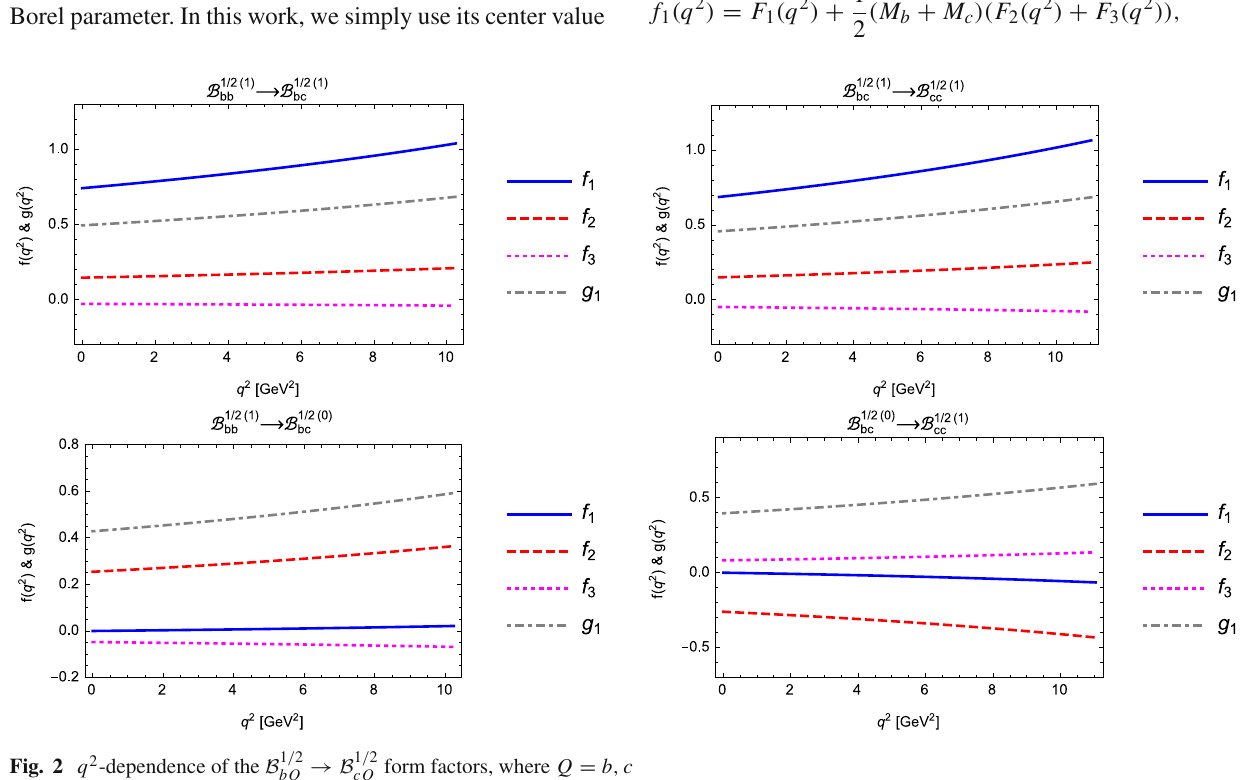
Fig. 2 q 2 -dependence of the B 1